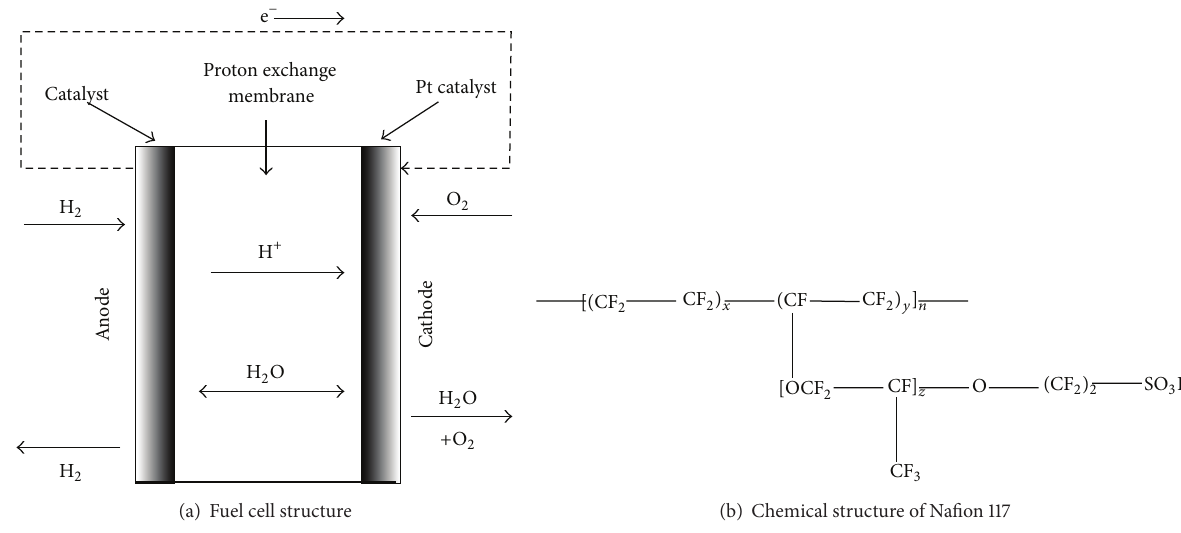
Figure 1: The structure of fuel cell and chemical structure of Nafion 117